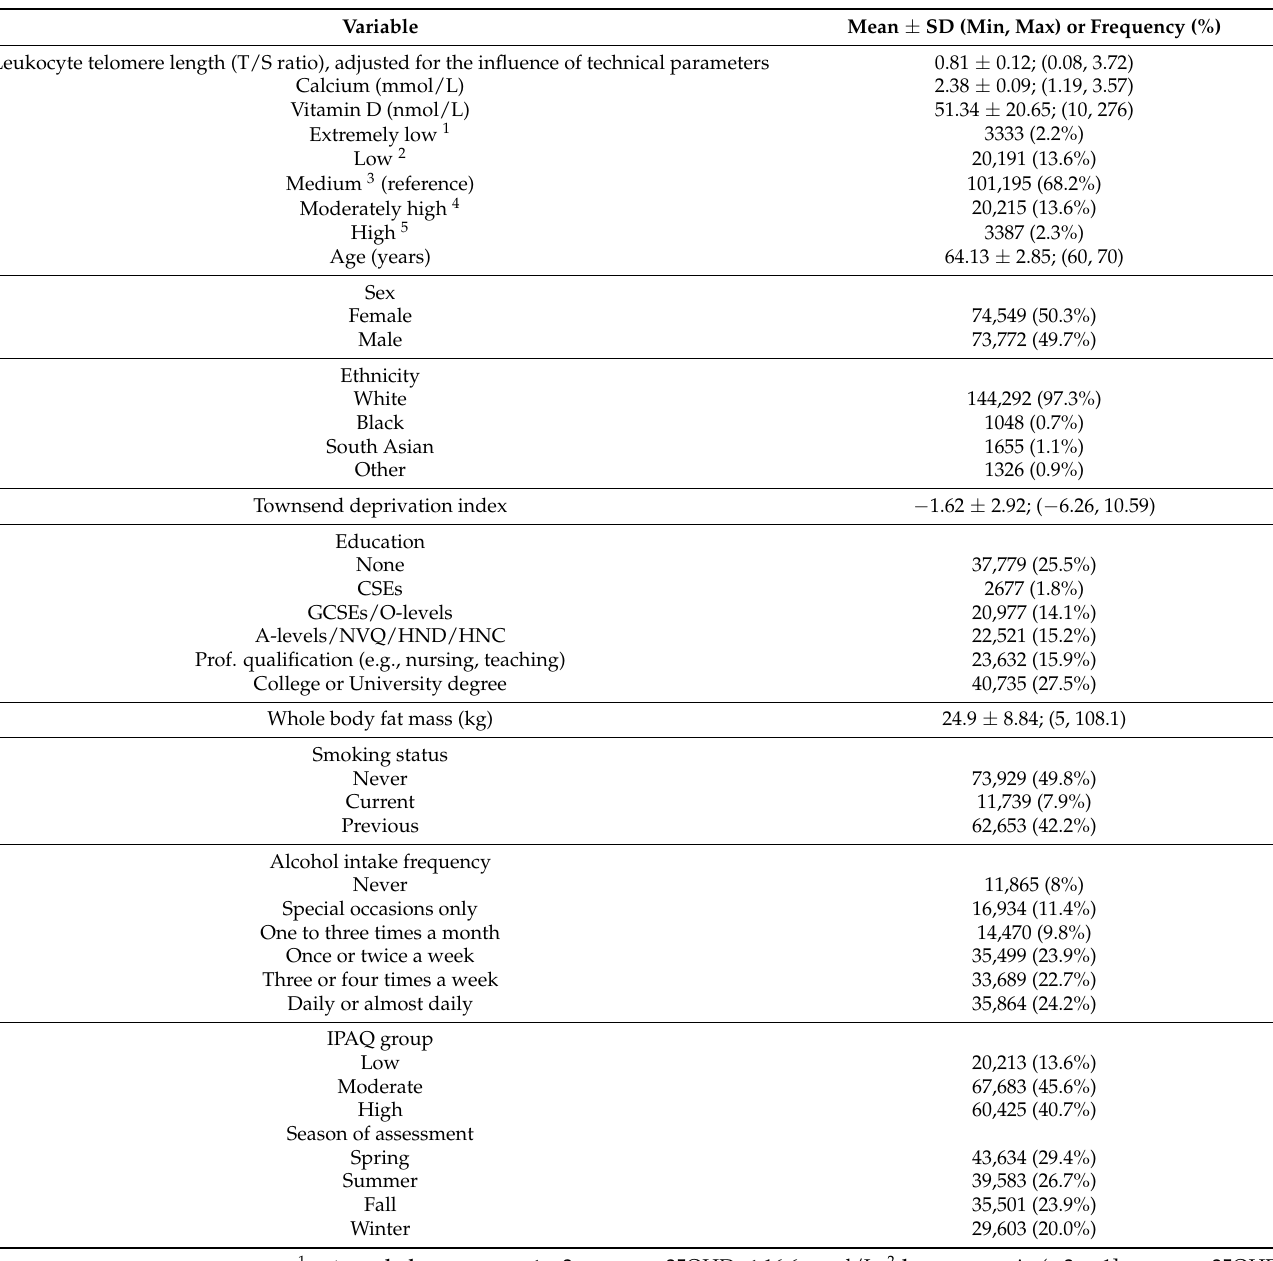
Table 2. Participant characteristics of the included